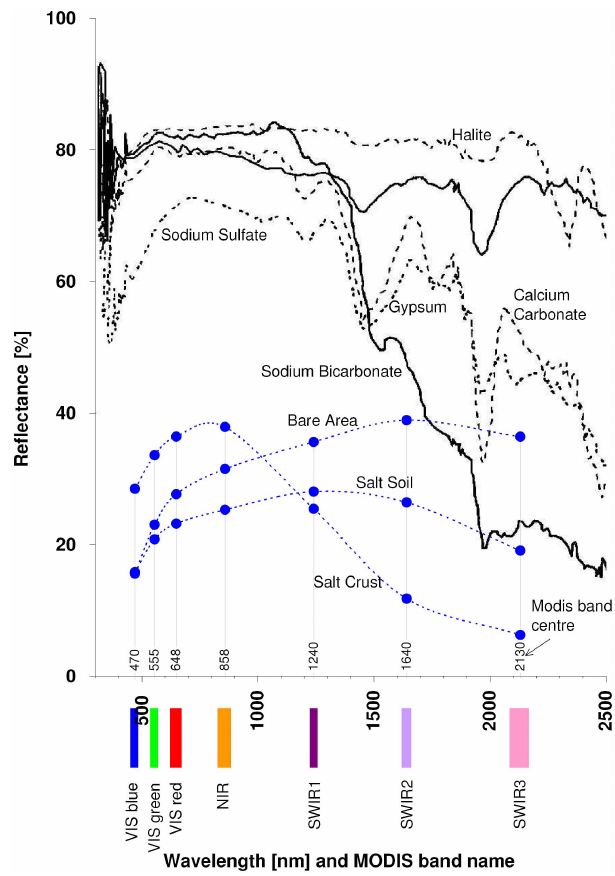
Fig. 5. Spectral signature variations of main land cover classes (bare area, salt soil and salt crust). Data recorded from pixels cov- ering the soil sampling sites respectively pixels selected for train- ing of the image classifier algorithm. Reflectance measurements (blue dots) were interpolated for better visual readability (blue dot- ted lines). For comparison with laboratory data the image back- drop shows spectral profiles of gypsum, halite, calcium carbon- ate, sodium bicarbonate, and sodium sulphate in the visible, near, and mid-infrared (400–2500nm). Data source: Metternicht and Zinck (2003); recorded by the GER 3700 Spectroradiometer.